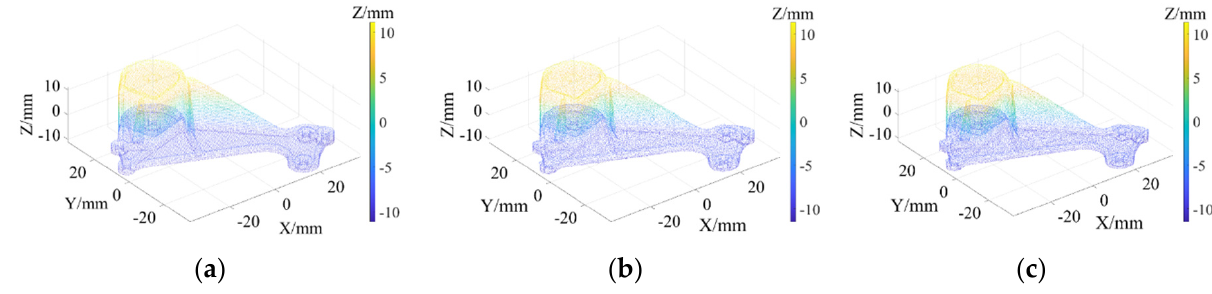
Figure 3. Ground-truth point cloud and the denoising results by R-SLDM under different noise intensities: ( a ) ground-truth; ( b ) R-SLDM ( σ = 0.2); ( c ) R-SLDM ( σ = 0.4 ).